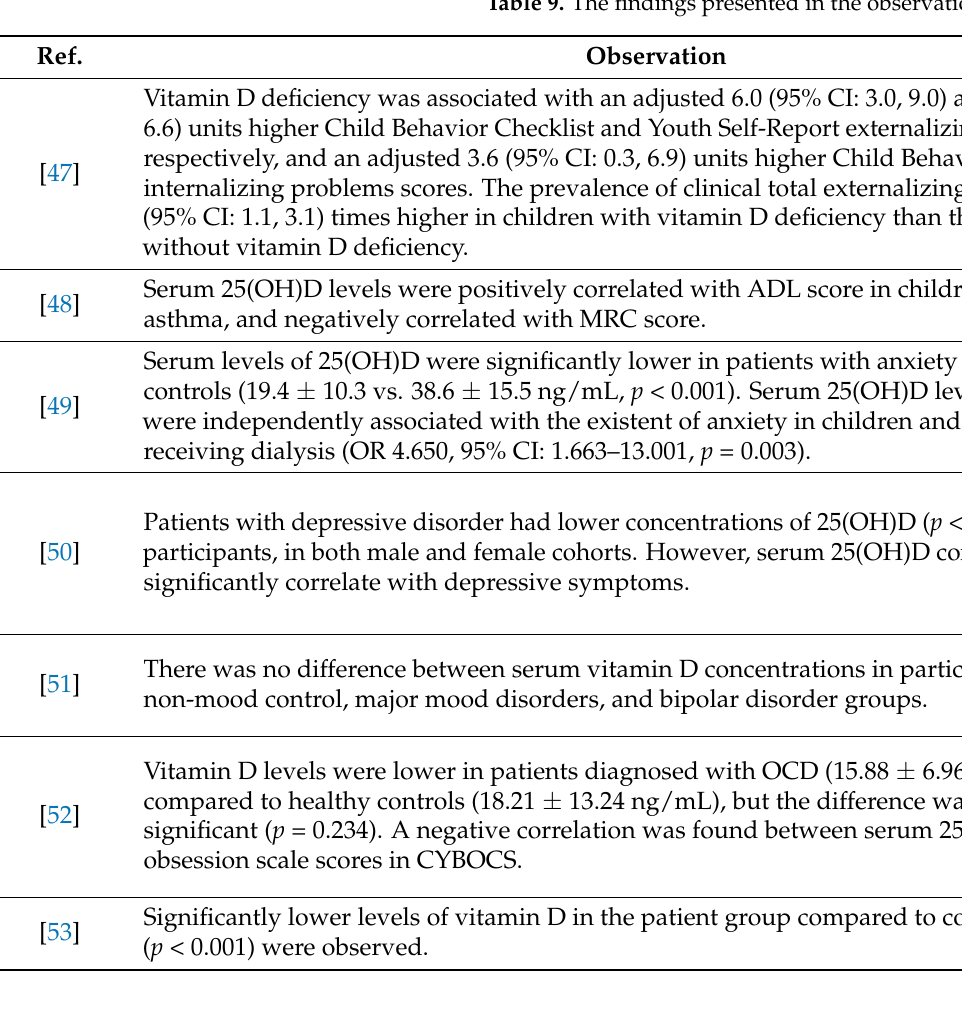
Table 9. The findings presented in the observational studies included to the systematic